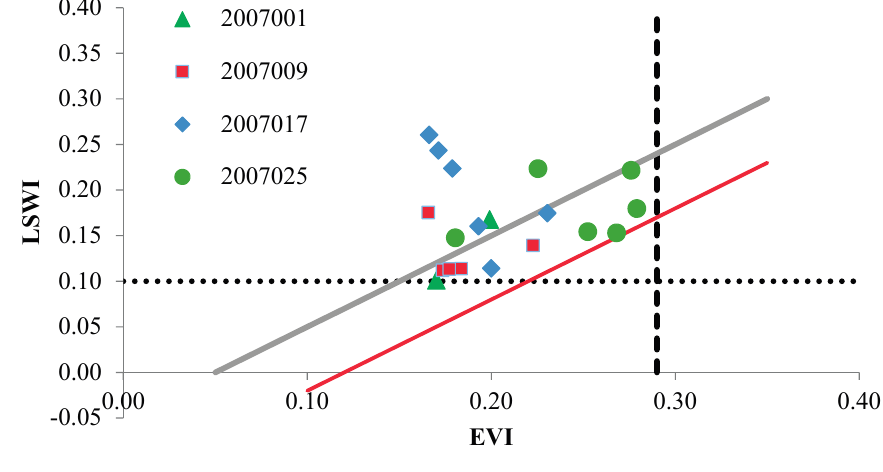
Figure 8. Characteristics of paddy rice fields reflected by EVI and LSWI in the transplanting period according to ground observation sites during 2006–2007 Rabi season. The red line is the threshold for potential rice in the transplantation season of Rabi , whereas the green line was threshold used for Kharif